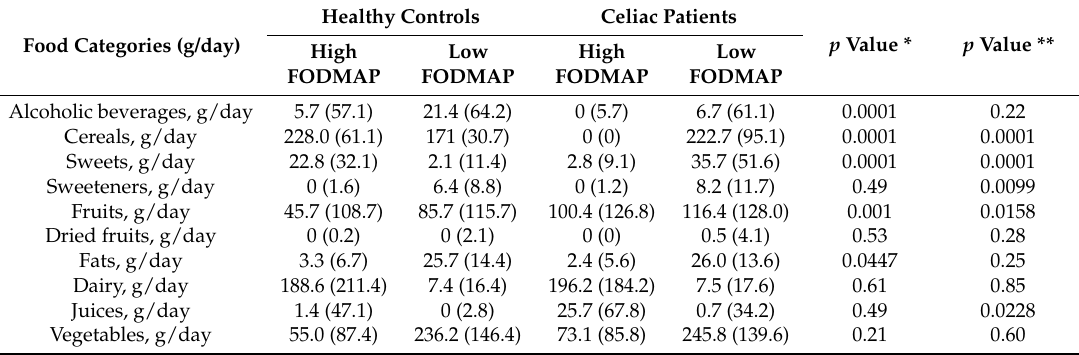
Table 3. Daily intake of food categories containing low and high amounts of FODMAP by celiac patients and healthy